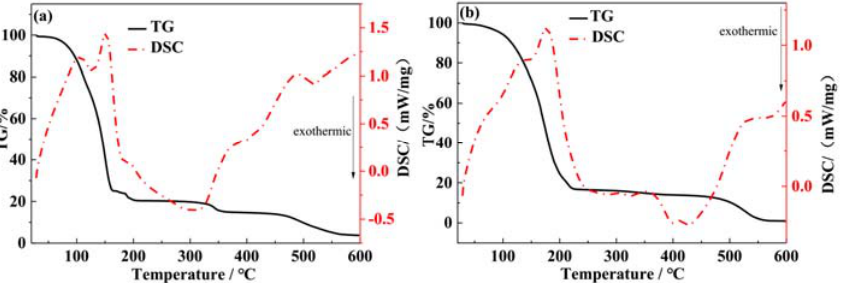
Figure 3. The TG-DSC curves with different ratios of dimethyl sulfoxide (DMSO) ( a ) 0%; ( b ) 10%.